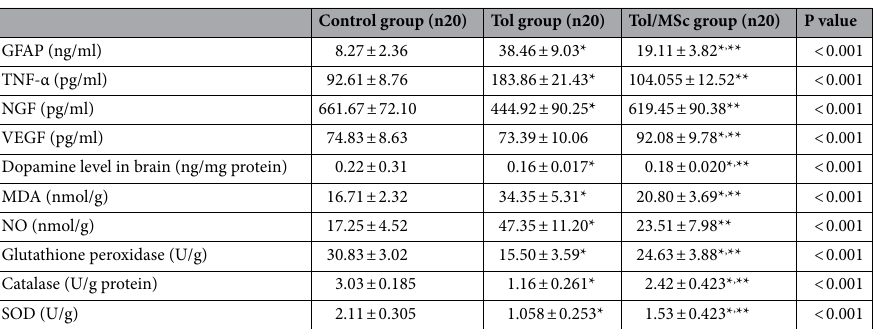
Table 1. Statistical comparison of biochemical parameters. Glial fibrillary acidic protein (GFAP), tumor necrosis factor-alpha (TNF-α), nerve growth factor (NGF), vascular endothelial growth factor (VEGF) levels, tissue dopamine level, and tissue oxidative stress parameters (MDA, nitric oxide) among different studied groups. One-way ANOVA, and Tukey HSD Post-hoc Test, P > 0.05: no significant differences, P < 0.05: significant differences. *Significant vs control group. **Significant vs Tol